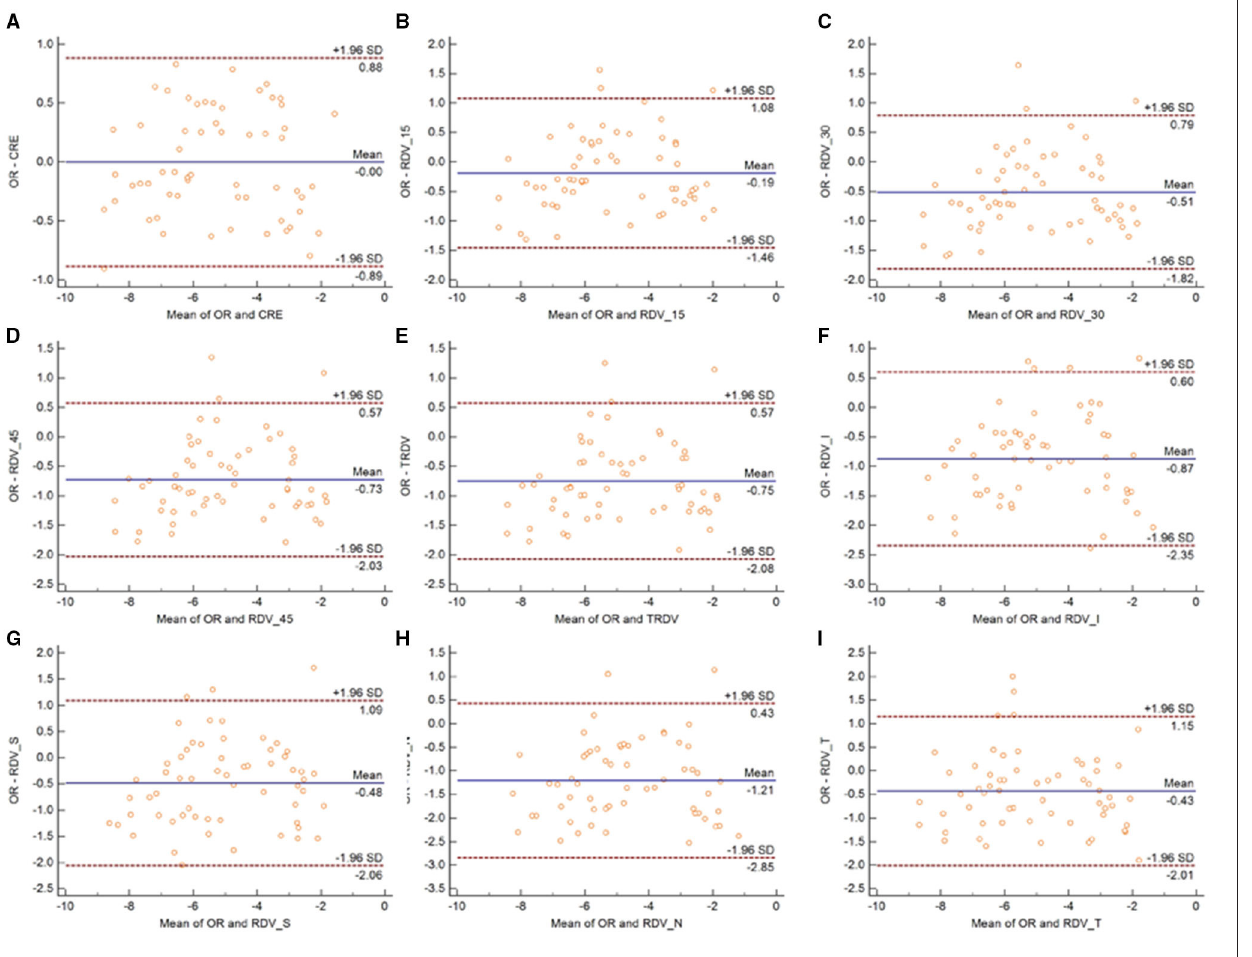
Frontiers in Medicine |